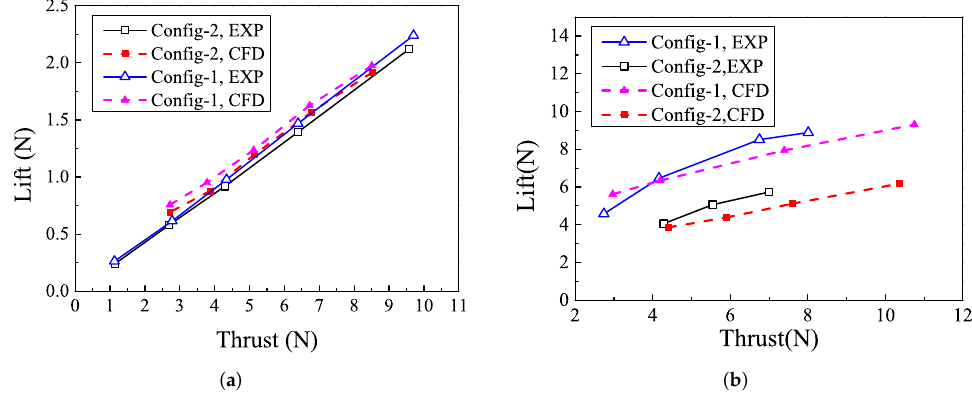
Figure 11. Comparison between test and CFD results. ( a ) Static Test; ( b ) Low-speed Test.